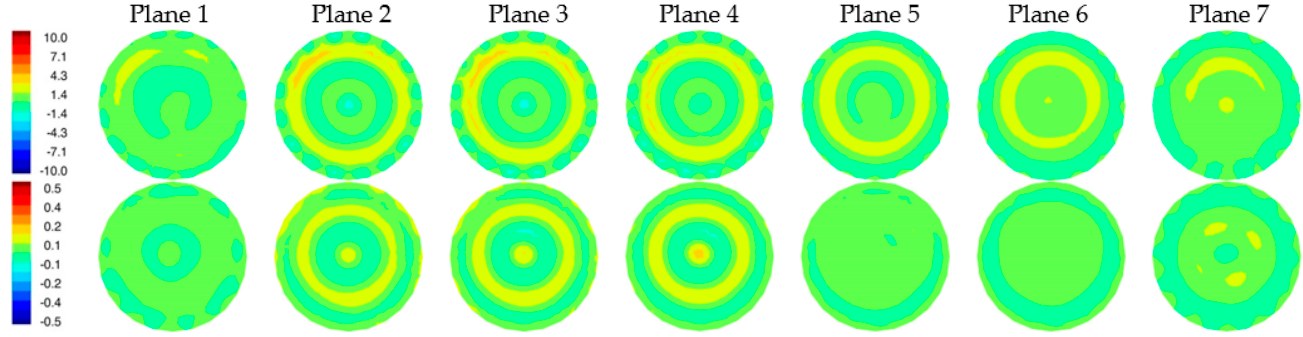
Figure 9. Difference images of reconstructions with and without skin shown in Figure 8 (permittivity images on top row and conductivity images on the bottom